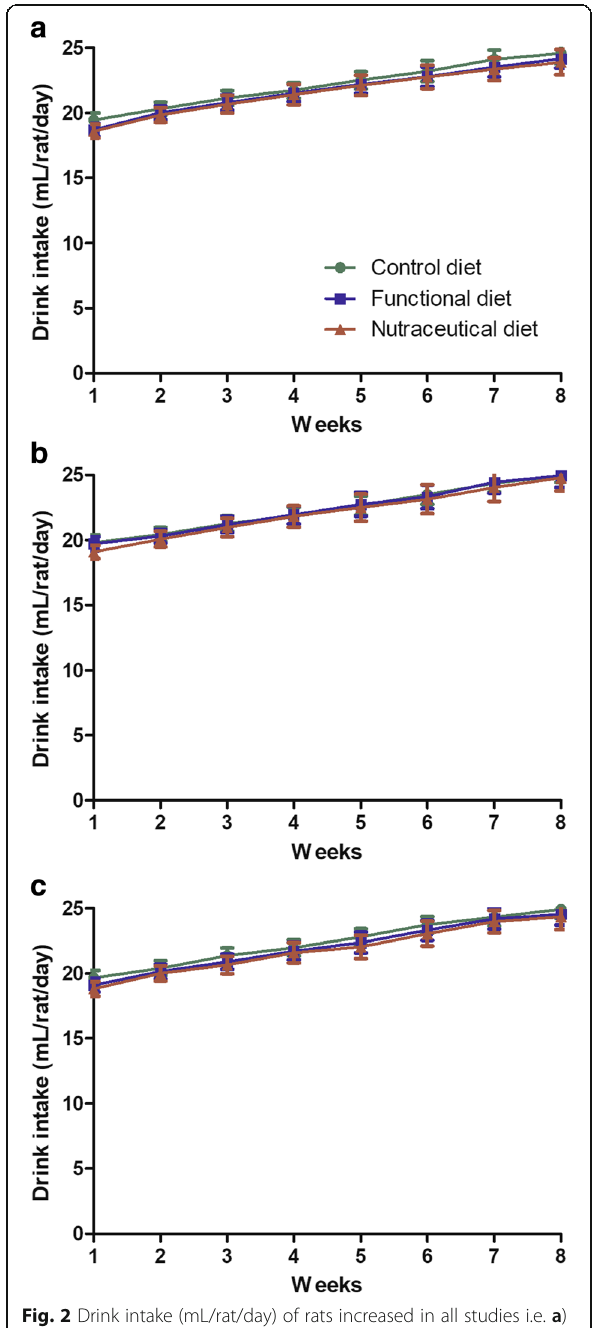
growth was occurring constantly but control groups ani- mals weight was more as compared to nutraceutical diet fed counterparts. In study І (Normal rats), the body weight increased from 135.72 ± 6.47, 134.09 ± 6.57 and